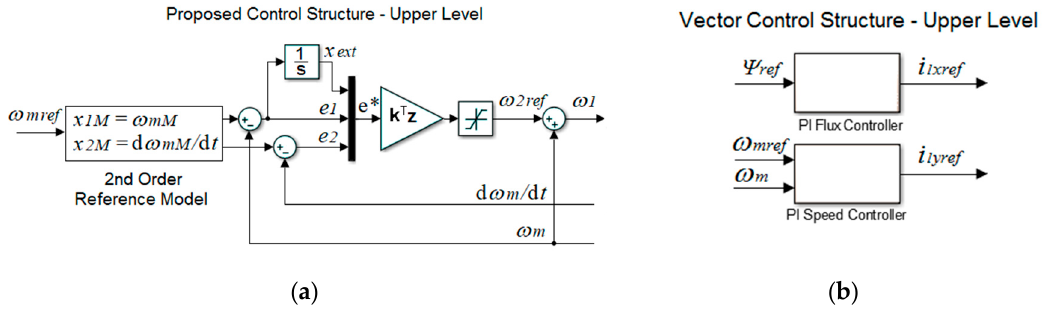
Figure 8. The upper control level: ( a ) of the designed control structure; ( b ) of the vector control structure.